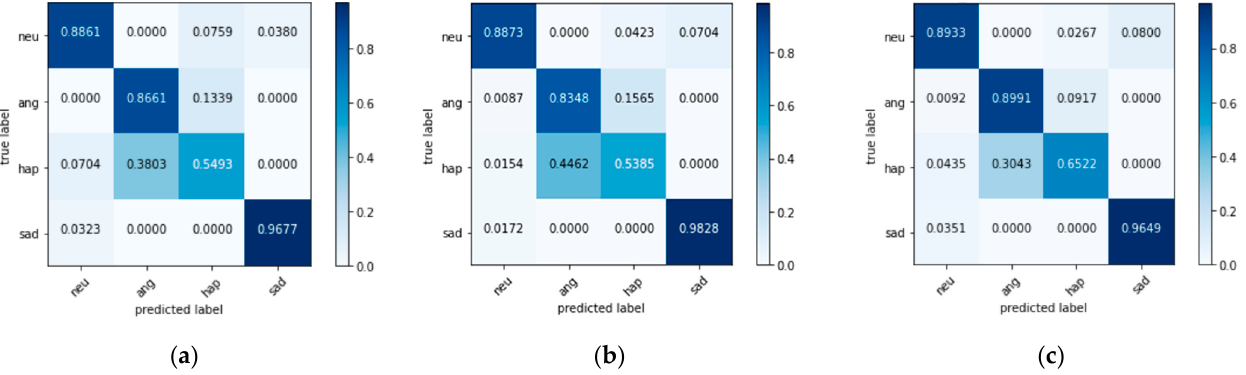
Figure 4. The confusion matrix of the EMO-DB corpus. ( a ) The confusion matrix for the MSFL_ST model. ( b ) The confusion matrix for the MTL_DNN model. ( c ) The confusion matrix for the MSFL model.